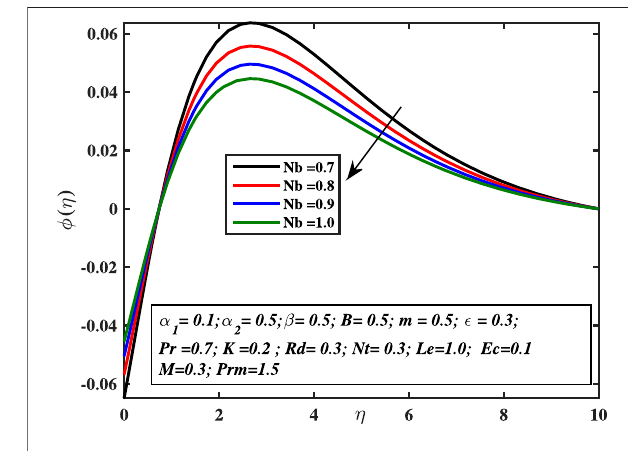
FIGURE 10 | Impact of Ec on the θ ( η ) curve.